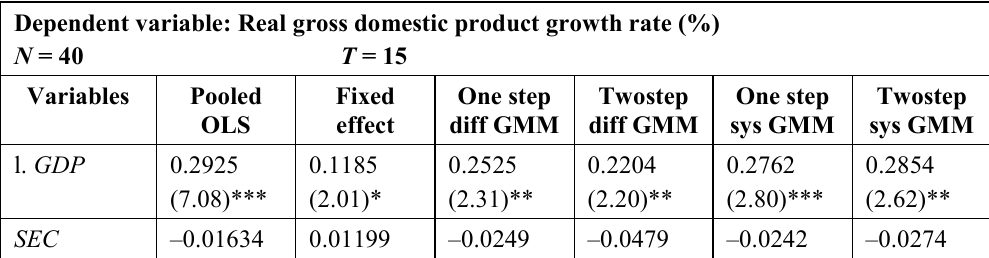
Table 4. Estimation Results of Dynamic Panel Data